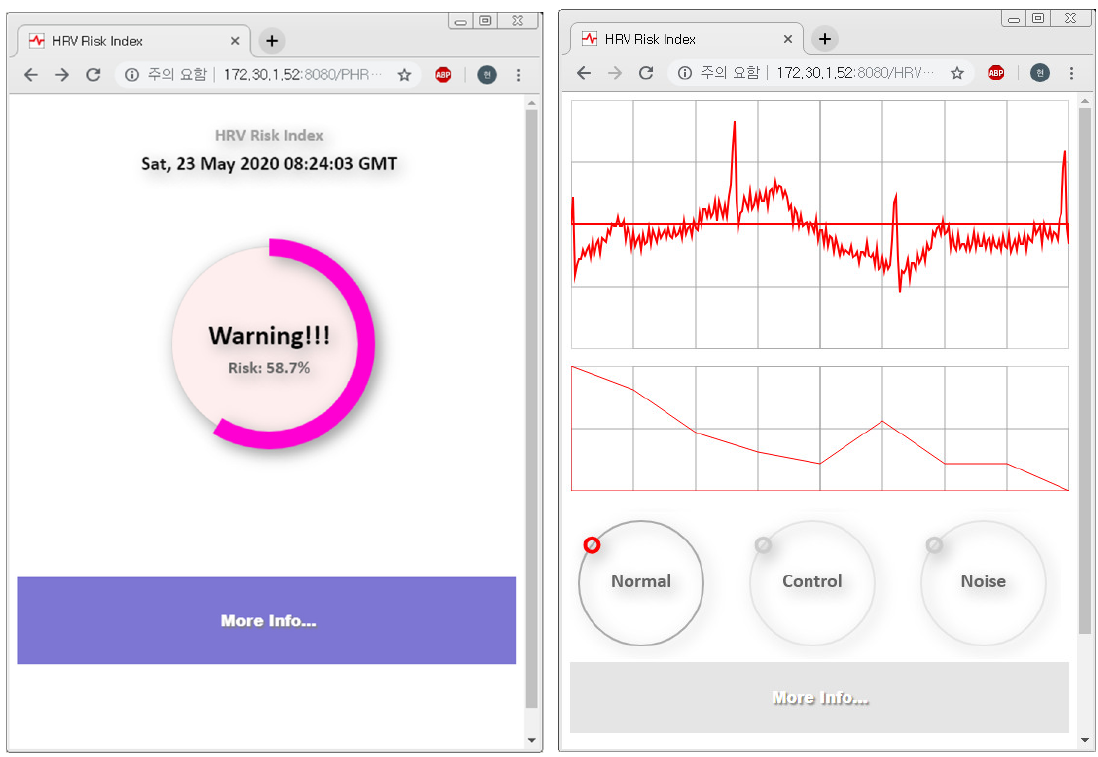
Figure 7. Result of the web service screen for providing risk index of cardiovascular disorder.